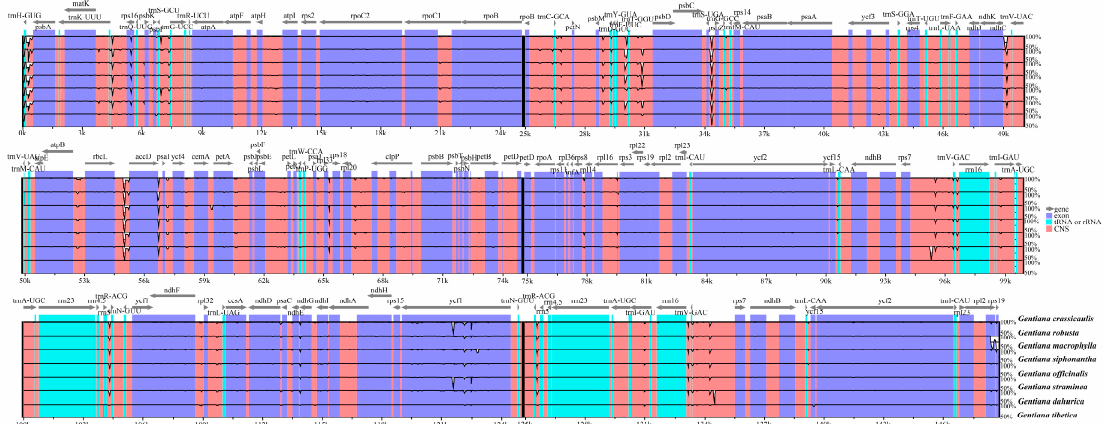
Figure 4. mVISTA percent identity plot comparing the eight chloroplast genomes of Gentiana sect. Cruciata with G. crassicaulis as a reference. The y -axis represents the percent identity within 50–100%. Genome regions are color-coded as protein coding (purple), rRNA, or tRNA coding genes (blue), and noncoding sequences (pink).